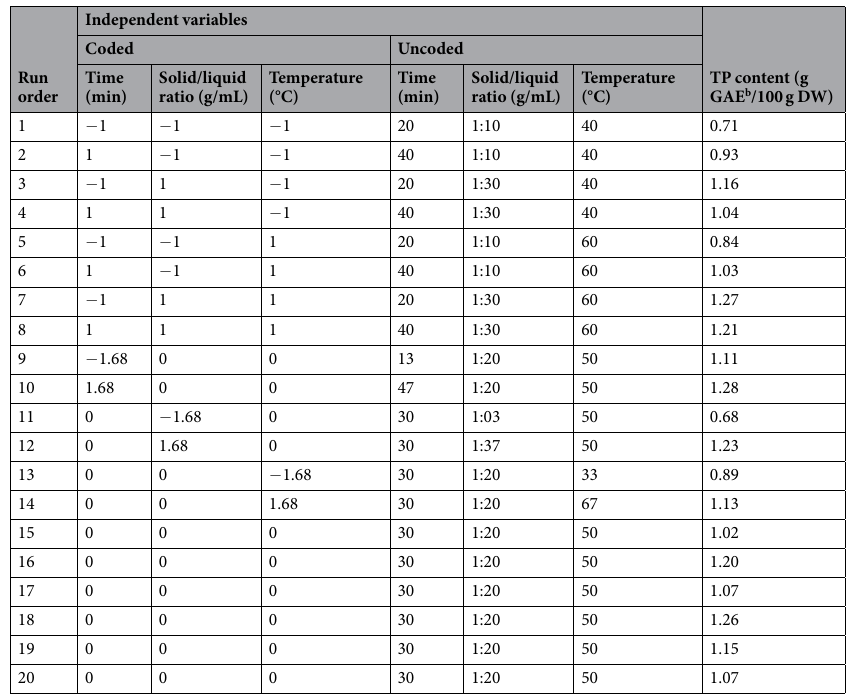
Table 1. Central composite circumscribed (CCC) design with five levels and three variables for phenolic compound extraction in D . indicum var. aromaticum flower and observed responses a . a Experimental results for TP content are mean value of triplicates. b Gallic acid